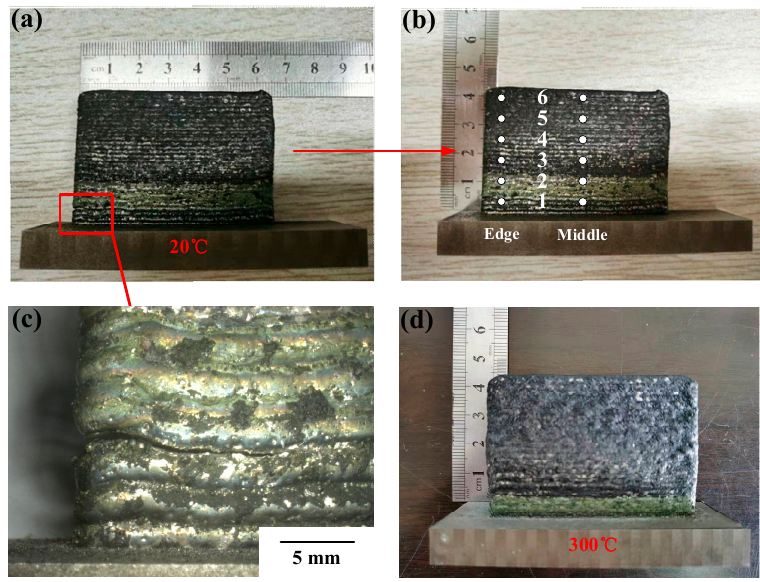
Figure 4. Macro morphology of the Stellite-6/Inconel 718 FGM thin-walled samples: ( a ) overall appearance (room temperature); ( b ) the measurement points located in different gradient areas; ( c ) partial crack areas; ( d ) overall appearance (300 °C).